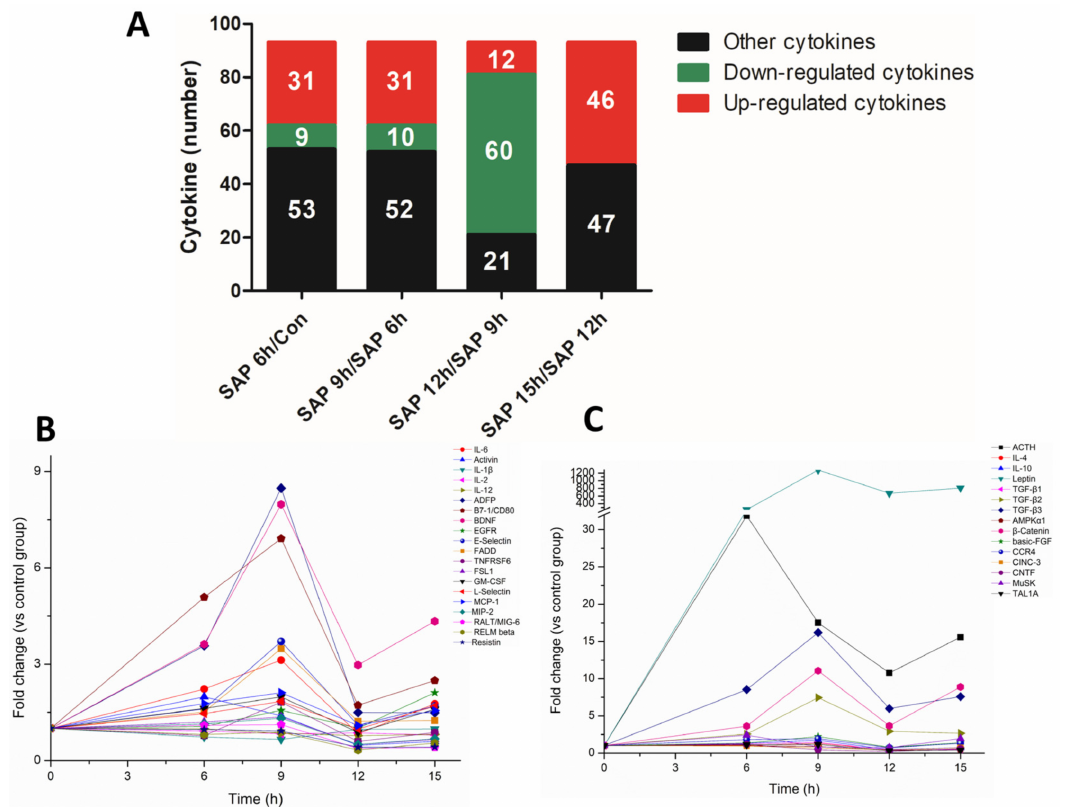
Figure 4. The trend of cytokine expression in SAP rats was not consistent with the disease progression. ( A ) Upregulated (fold change > 1.3) and downregulated (fold change < 1.3) cytokine numbers in different groups compared to the previous time point. ( B ) Alterations in proinflammatory cytokines with time. ( C ) Alterations in anti-inflammatory cytokines with